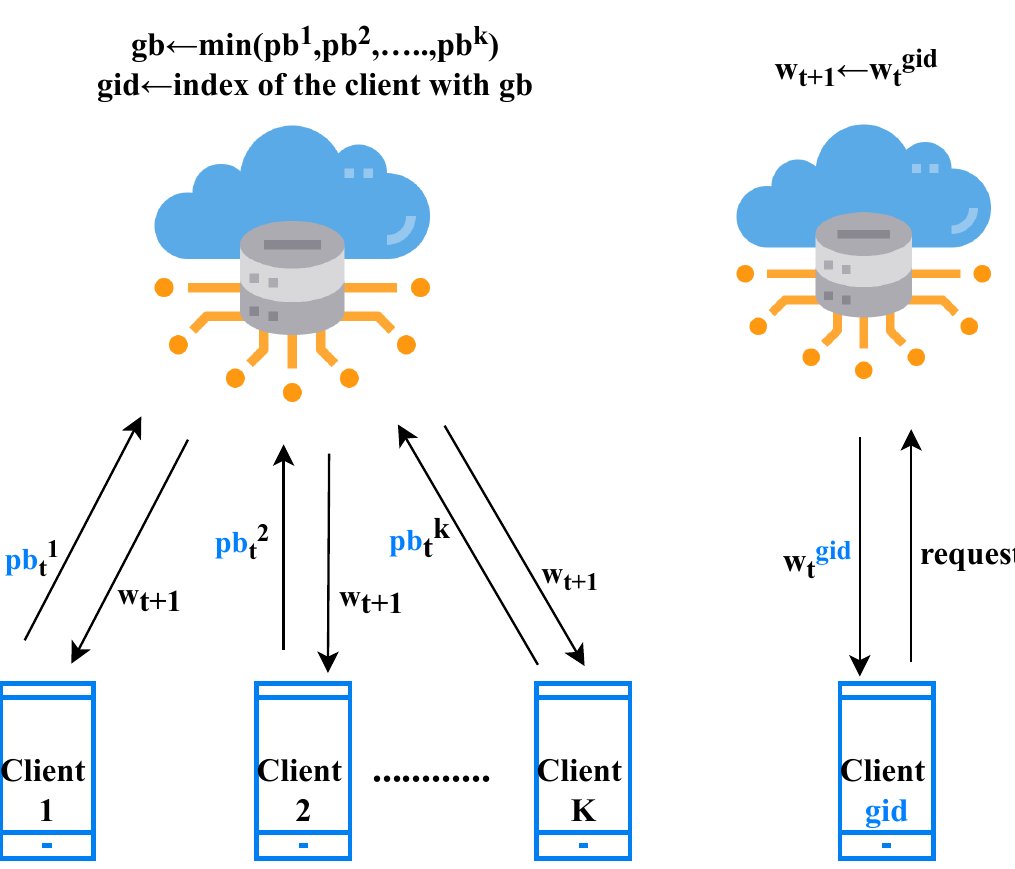
Figure 3. FPS Optimization Process. The server receives a client’s score and requests a learning model from the client who submits the optimal value to set it as a global